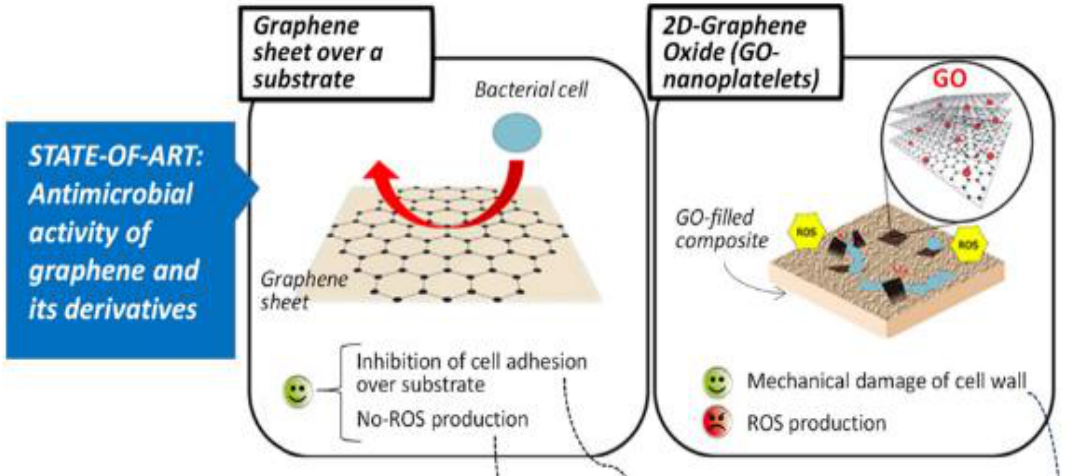
Figure 4. Graphene and GO have antimicrobial and antibiofilm properties, due to their structure and the presence of oxygen-containing functional groups that improve hydrophilicity and facilitate ROS generation [66].